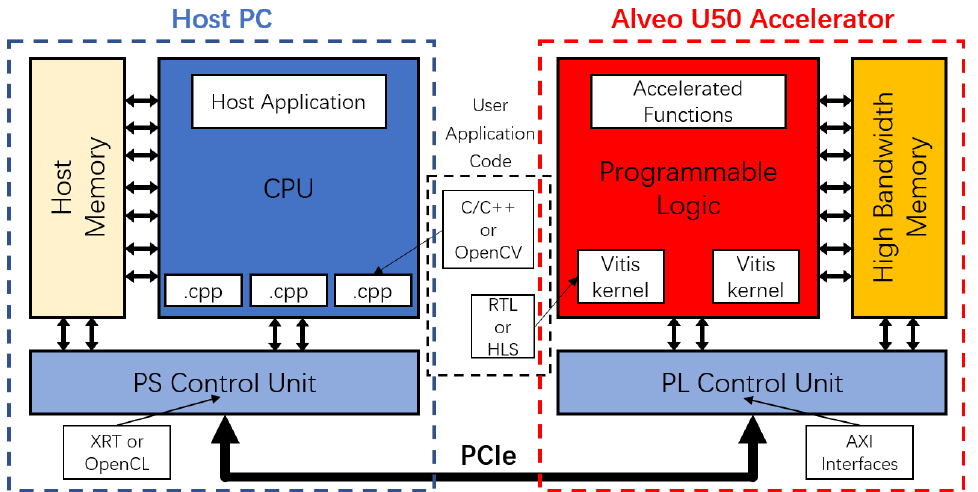
Figure 10. Architecture of Xilinx Vitis development platform and devices in hardware